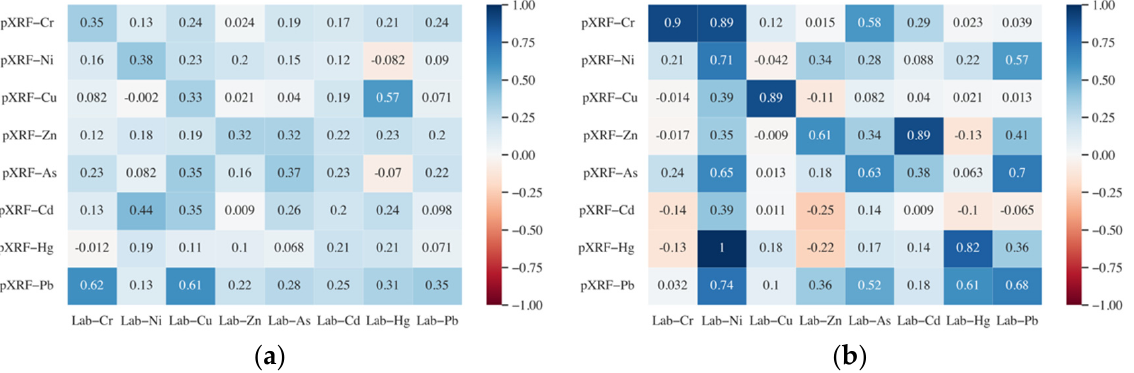
Figure 7. Pearson correlation between pXRF measurement with laboratory concentrations of samples in pXRF low-value ( a ) and high-value datasets ( b ). In figure b, the high coefficients between laboratory data of Ni with pXRF measurement of Hg and Cr were due to the small sample size.